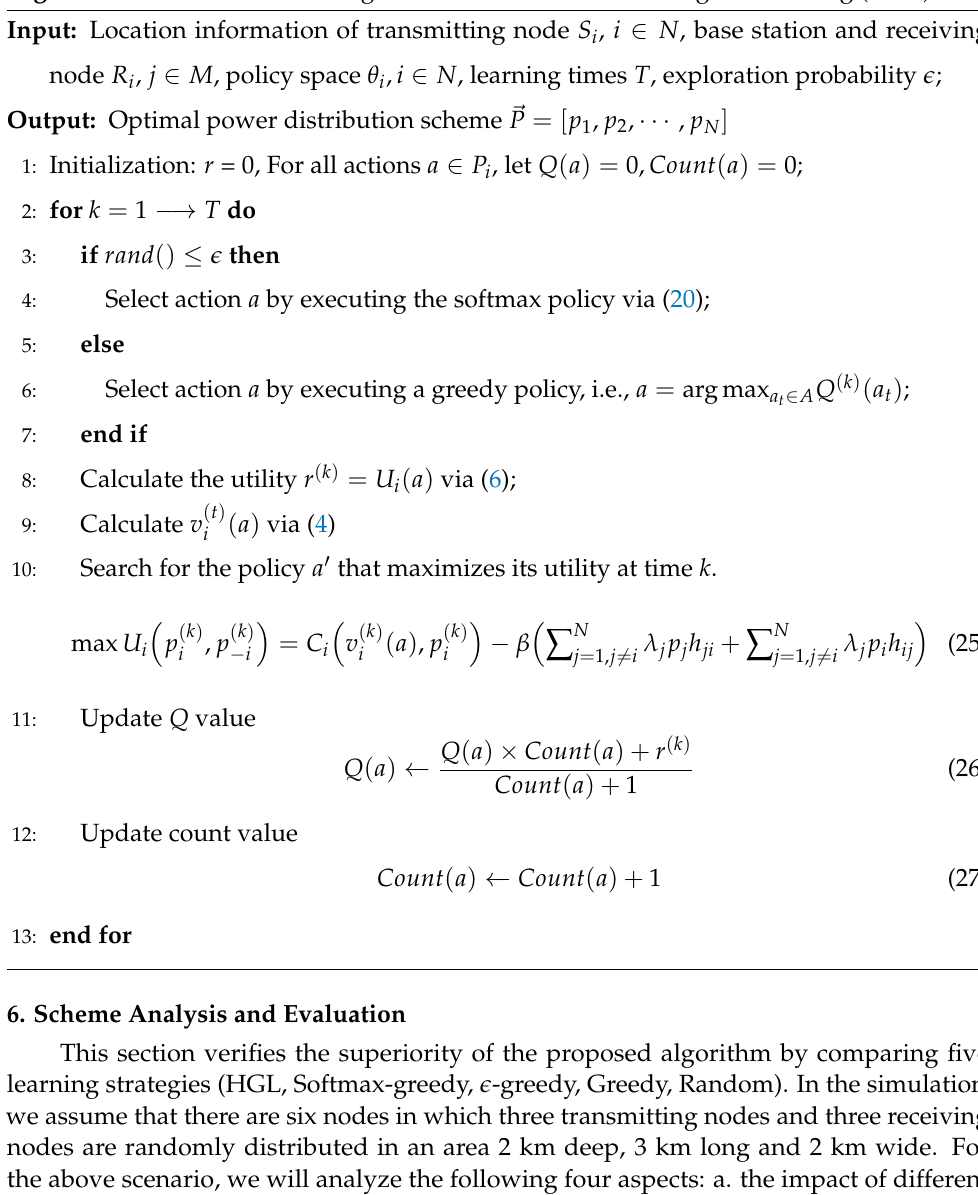
Algorithm 2 Power allocation algorithm based on hierarchical game learning